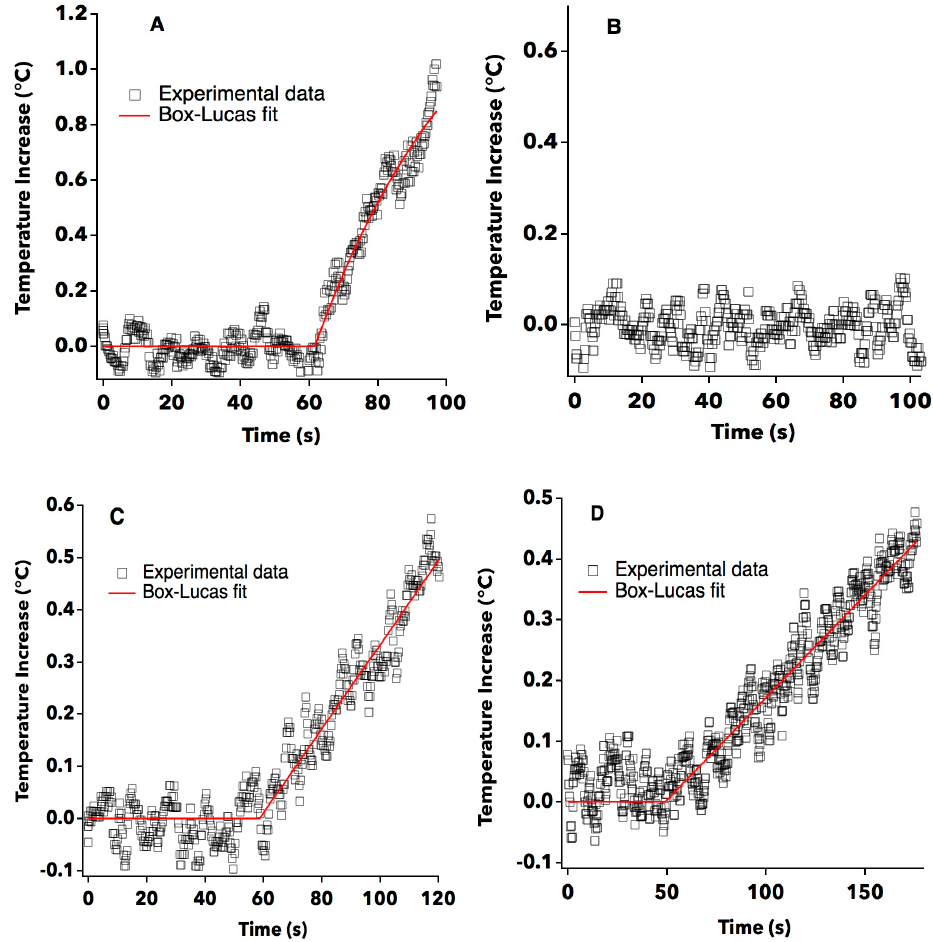
Figure 4. Temperature increase and Box-Lucas fit (red line) versus time for well dispersed MNPs ( A ), cerium oxide nanoparticles ( B ), and aggregates containing 17% ( C ) and 100% ( D ) of iron oxide nanoparticles, respectively. Magnetic field was applied after 60 seconds recording.